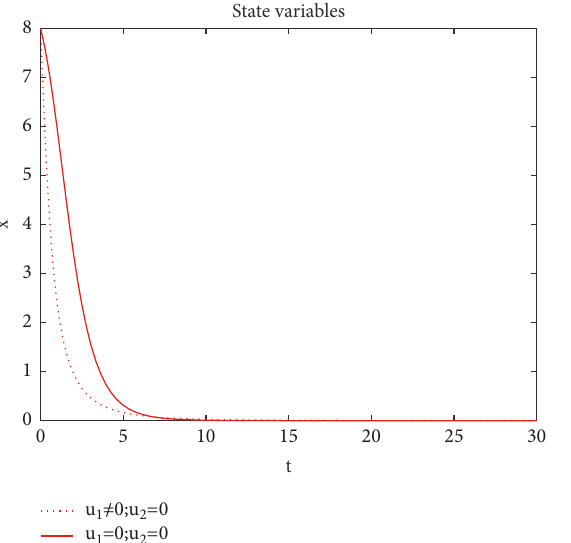
Figure 3: Evolution of number of 𝑧(𝑡) with or without control.